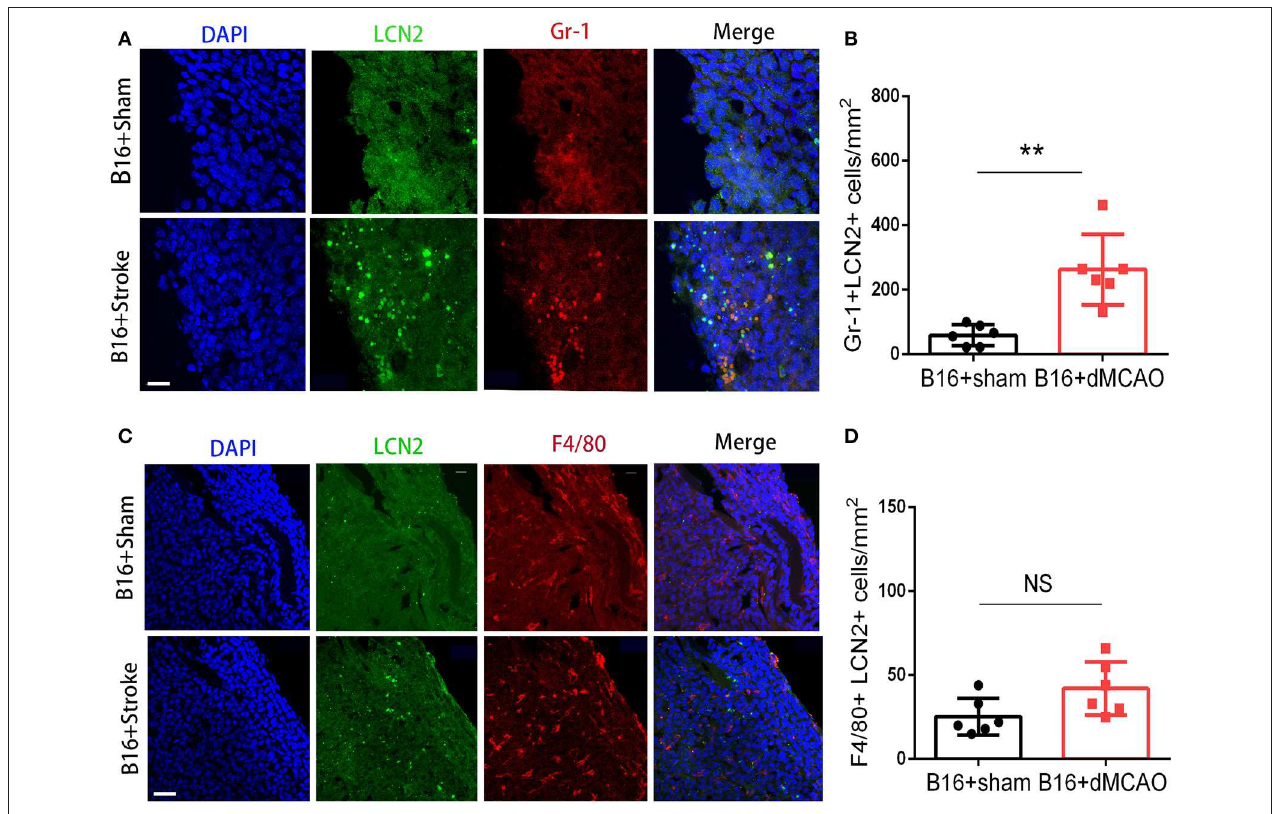
FIGURE 6 | LCN2 expression in Gr1 + and F4/80 + cells in the tumor. Tumor tissue were collected for immunofluorescence staining 3 days after sham or stroke surgery. (A,B) Representative images and quantification of LCN2 and Gr1 double staining in the tumor after stroke. Scale bar = 10 µ m. N = 6/group. (C,D) Representative images and quantification of LCN2 and F4/80 double staining in the tumor after stroke. Scale bar = 20 µ m ( n = 6/group. ** P ≤